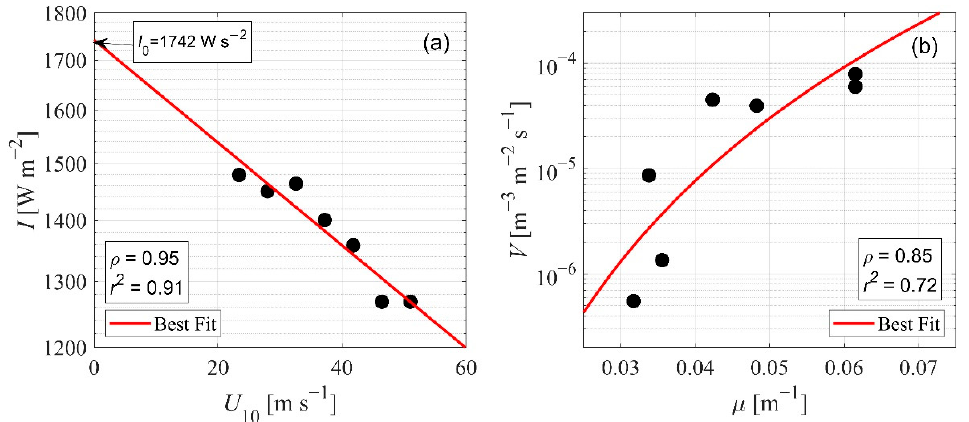
Figure 1. The recalibration of laboratory observations of Toffoli, Babanin, Donelan, Haus and Jeong [46]: ( a ) the attenuated laser intensity I against wind speed U 10 and ( b ) the sea spray volume flux V against the laser attenuation coefficient µ . The red line defines the best data fit based on the power